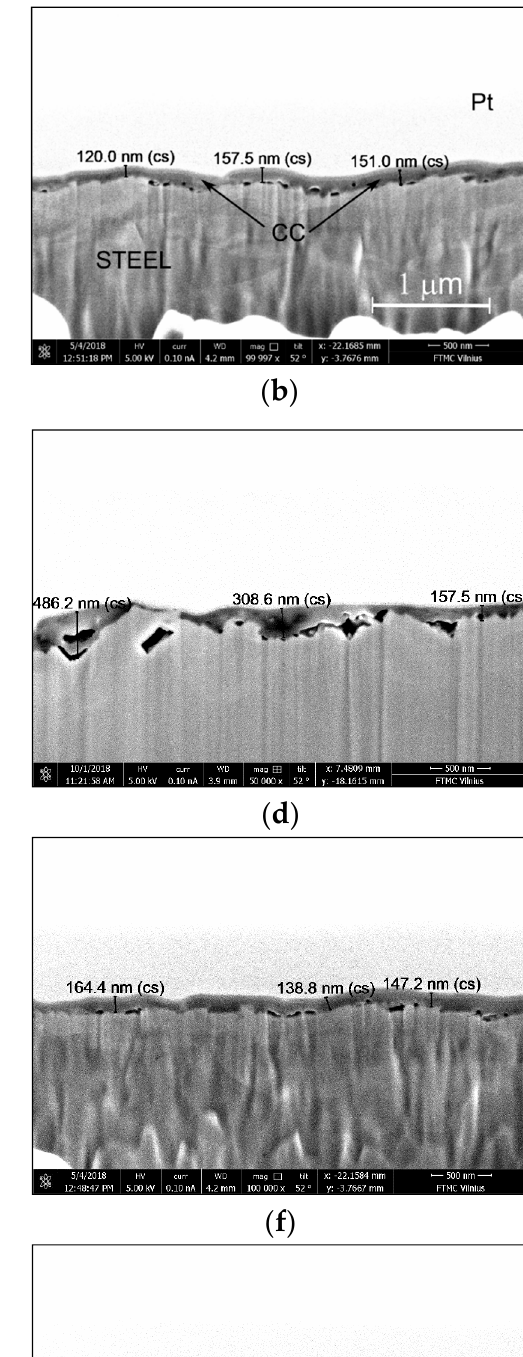
Immersion time, min 132 Figure 1. Variation of open circuit potential ( E oc ) of: 1—steel electrode in a solution of 0.15 M H 3 PO 4 + 0.003 M H 2 C 2 O 4 + 0.02 M NaNO 3 + 0.1 M Na 2 MoO 4 ; and Fe/P-Mo electrodes in solutions: 2—0.05 M Ce(NO 3 ) 3 ; 3—0.05 M Ce(NO 3 ) 3 + 0.025 M Na 2 SO 4 . 3.2. Surface Morphology and Inner Structure A cracked “dried riverbed” morphology is typical for the molybdate-containing con- version coatings, what has been reported by a number of authors [8,22,25] and such mor- phology is observed in the case of the deposited Fe/P-Mo coatings as well. SEM image of the sample is presented in Figure 2a. The presence of surface cracks in µm range or larger could be related to the increase of stress induced by the film thickness. Alternatively, the cracks could form during the drying procedure performed at the end of the conversion process. The quality of deposited Fe/P-Mo coating appeared to be significantly influenced by the process duration. The increase in the conversion time up to 0.5 h led to the increase in the density of cracks in the film, therefore the process duration was limited to 20 min.